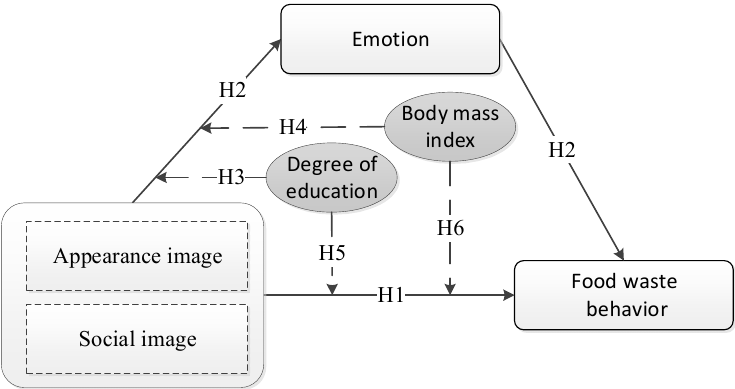
Figure 1. Conceptual model of food waste behavior.